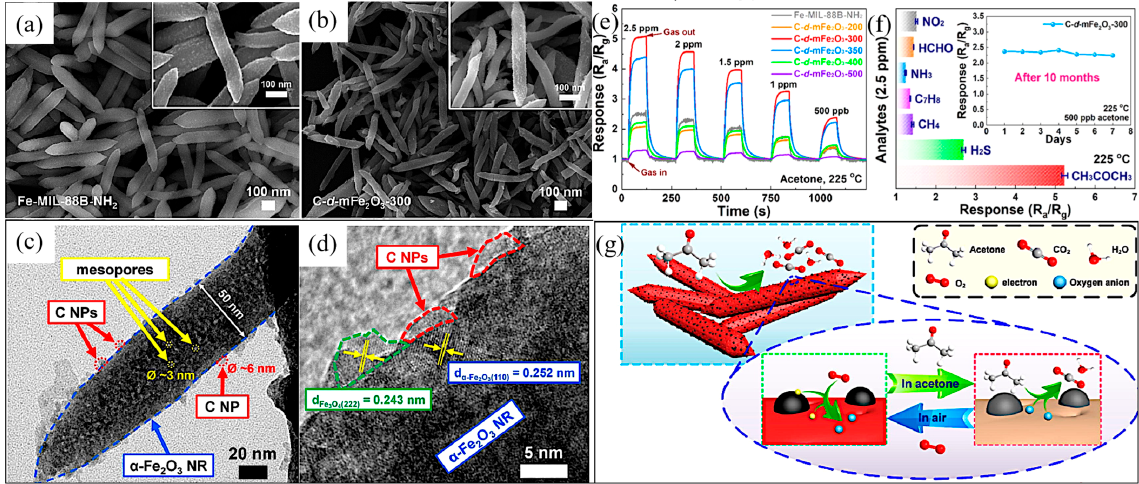
Figure 3. Low- and high-magnification (inset) SEM images of ( a ) Fe-MOF precursor (Fe-MIL-88B- NH 2 NRs) and ( b ) MOF-derived products obtained under 300 ◦ C; ( c ) TEM and ( d ) HRTEM images of as-obtained carbon nanoparticles decorated mesoporous α -Fe 2 O 3 NRs (C-d-mFe 2 O 3 -300 NRs); ( e ) Dynamic response curves of gas sensors based on Fe-MIL-88B-NH 2 and C-d-mFe 2 O 3 - x ( x = 200, 300, 350, 400, and 500) NRs facing different concentrations (0.5–2.5 ppm) of acetone at 225 ◦ C; ( f ) Responses of C-d-mFe 2 O 3 -300 sensor to various gases including NO 2 , H 2 S, NH 3 , C 7 H 8 , CH 4 , HCHO, and CH 3 COCH 3 with the same concentration of 2.5 ppm; ( g ) Schematic illustration of the acetone sensing process by C-d-mFe 2 O 3 -300 NRs